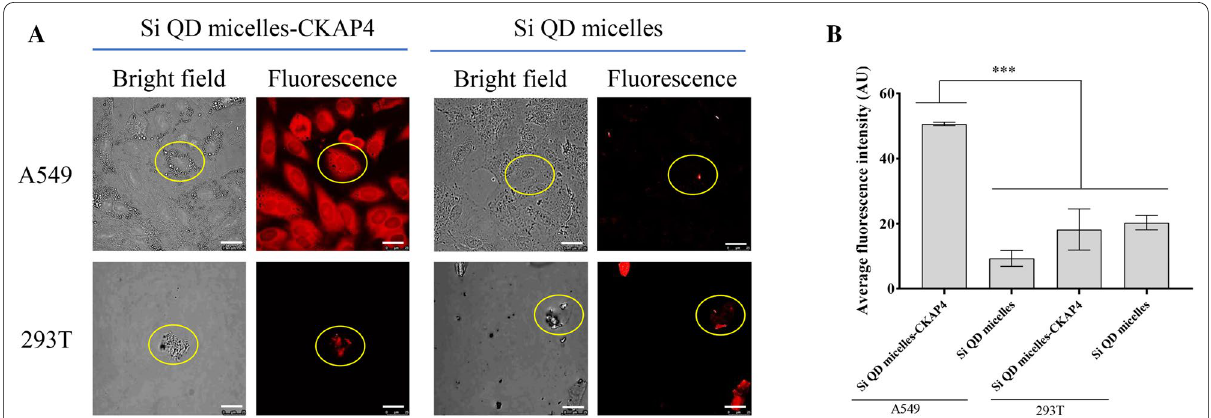
Fig. 4 Detection of the capability of Si QD micelles-CKAP4 targeting to A549 cells in vitro. a A549 and 293 T were incubated with Si QD micelles-CKAP4 and Si QD micelles (the concentration of Si 150 µg/ml) at 37 ℃ for 2 h. After discarding the supernatant and washing twice, cells were pictured by confocal laser scanning microscope (Bar, 25 µm). b A quantitative analysis of mean fluorescent intensity was measured by ImageJ ( n 3; mean SD; one-way ANOVA with Dunnett’s post test; *** P < 0.001) = ±